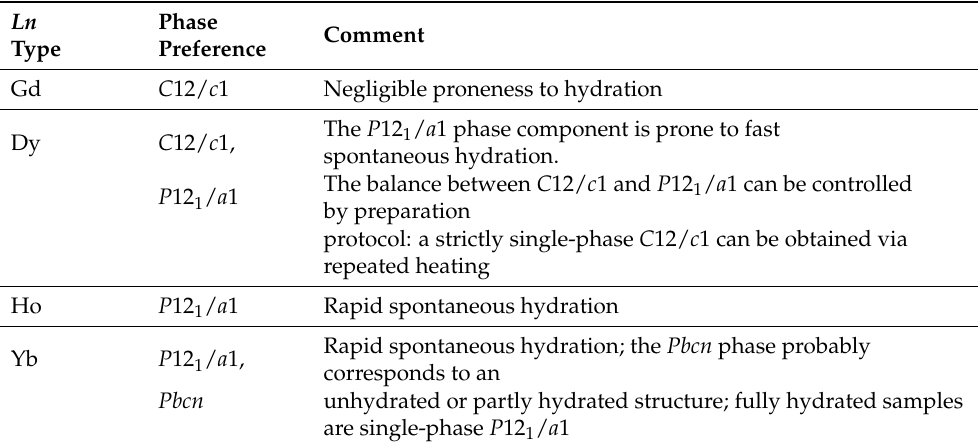
Table 5. Summary of structural features of heavy Ln tungstates under